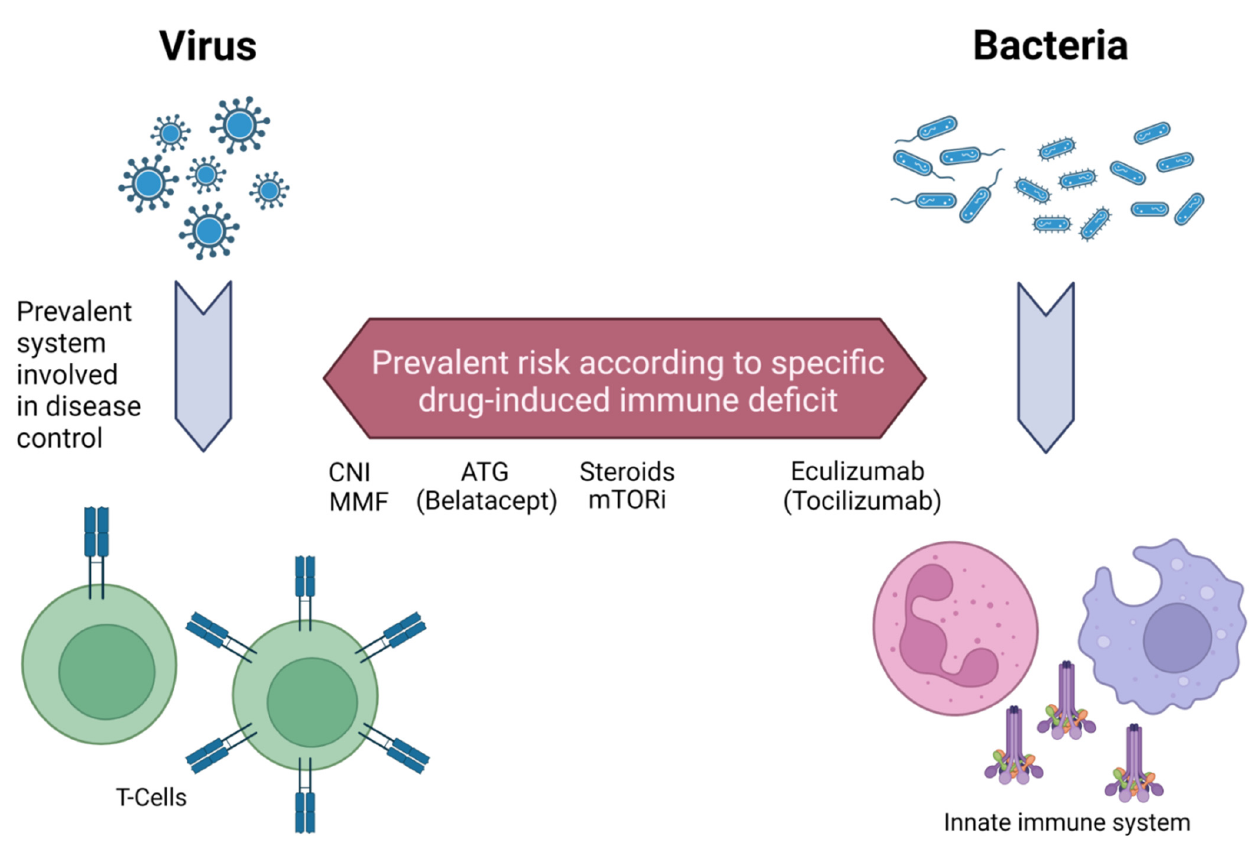
Figure 1. A schematization of immune system prevalent activation during viral and bacterial